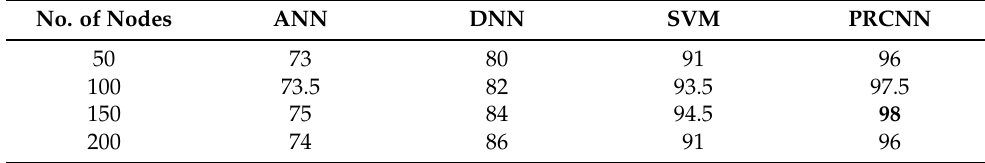
Table 6. Specificity Comparison Analysis between proposed and existing classifiers.